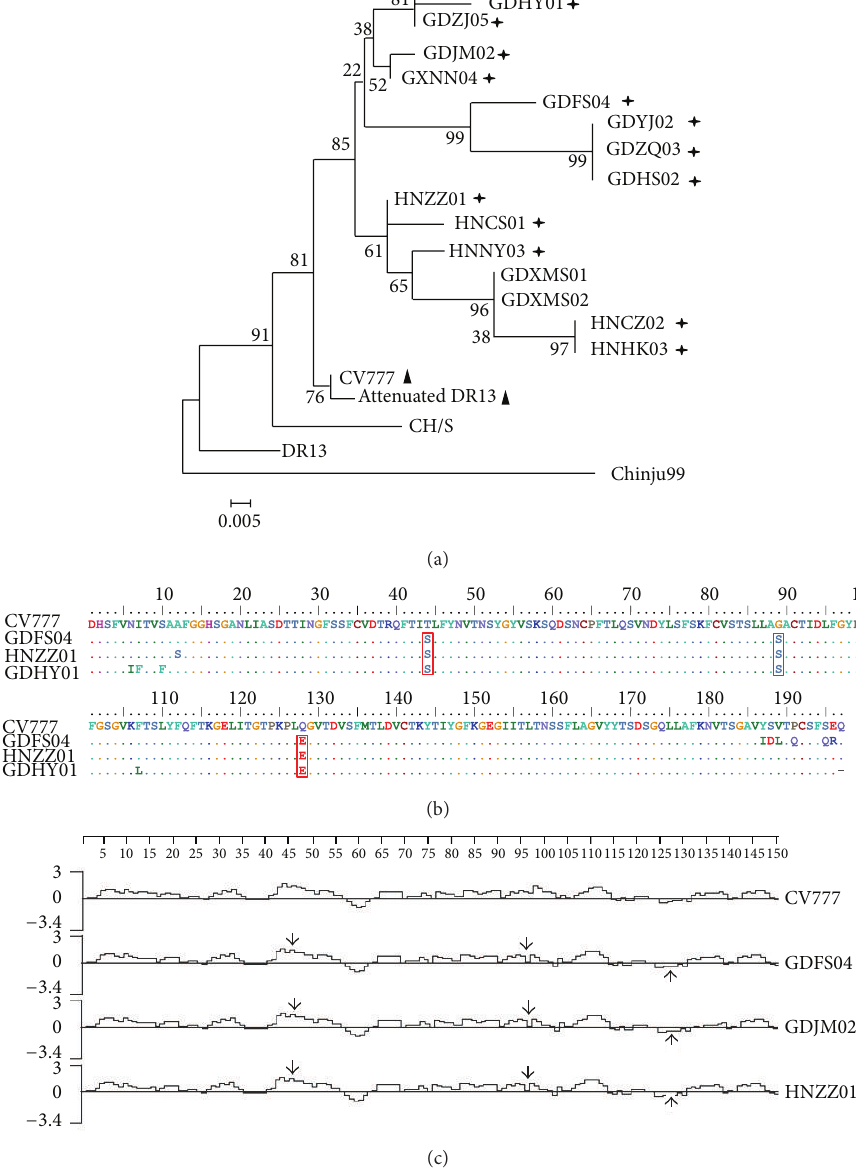
Figure 1: Comprehensive analysis of S genes from current PEDV with reference strains. (a) Phylogenetic analysis based on S aa; (b) point mutations analysis of S aa; (c) hydrophobic analysis of S aa. Phylogenetic tree is constructed by the neighbor-joining method with the MEGA 4.0 program. The percentage bootstrap support (per 1000 replicates) is indicated by the values at each node. Cross asterisk indicated present isolates; triangle indicated attenuated strains; box indicated point